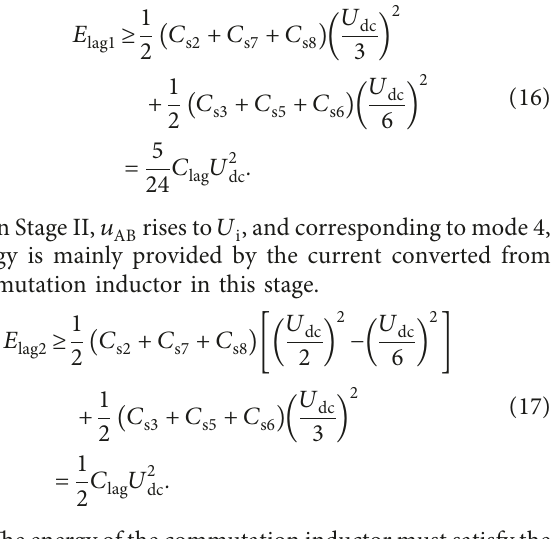
Figure 17: Main waveforms when S